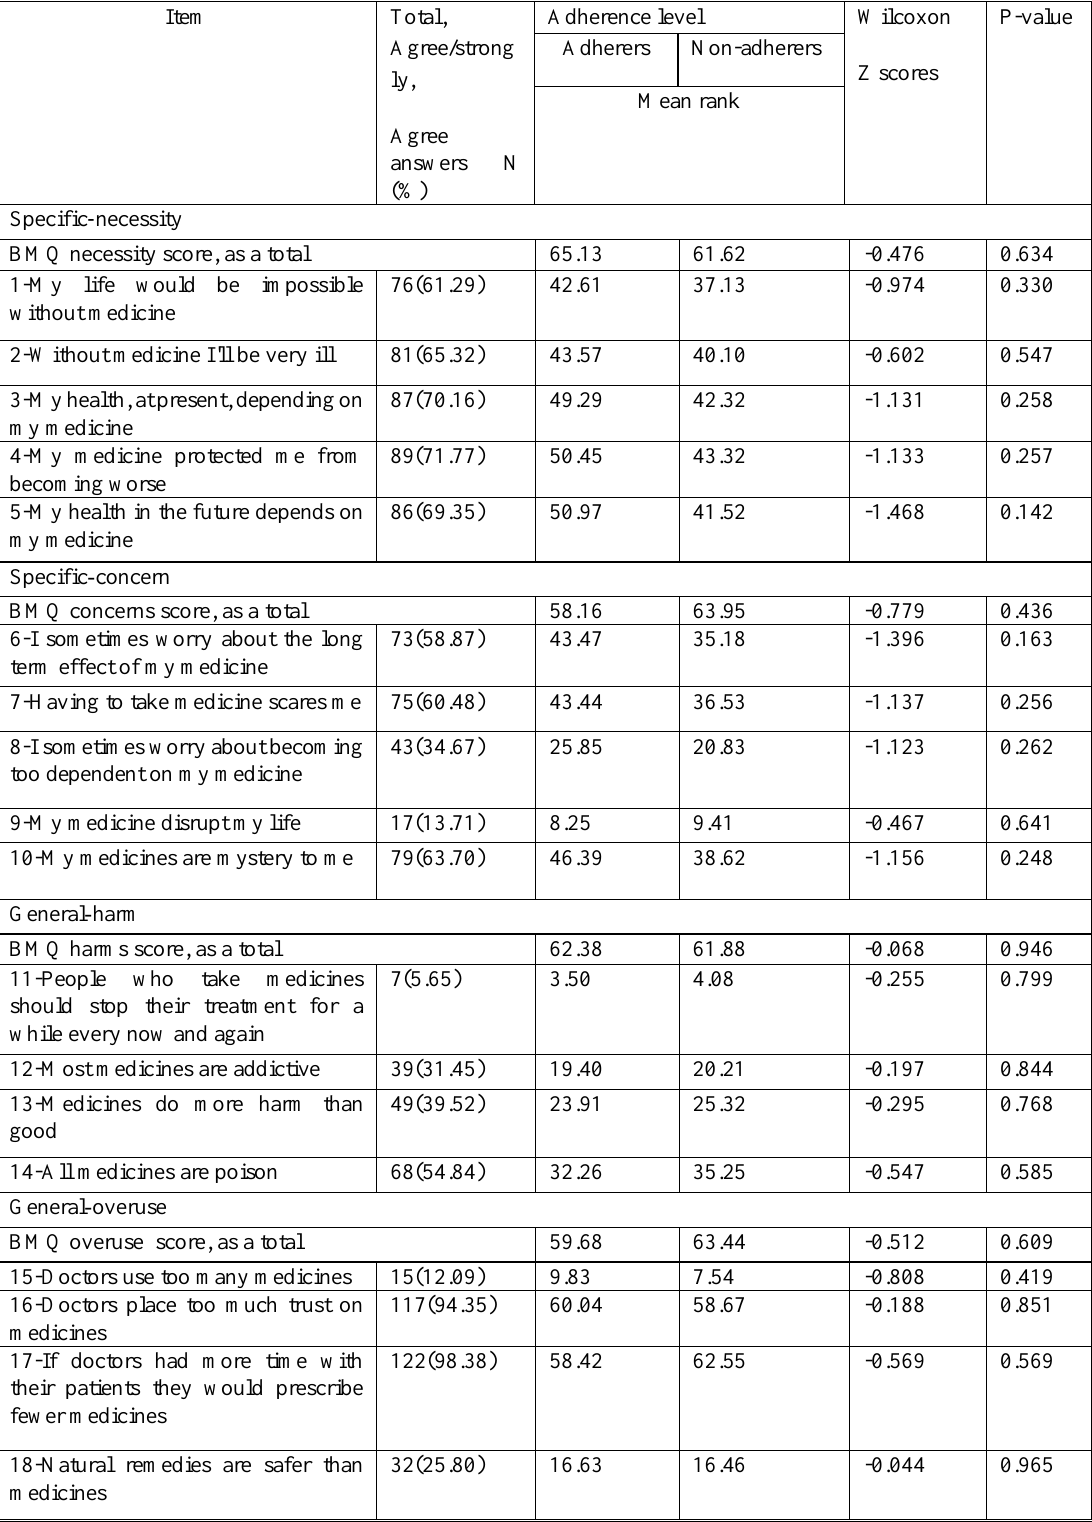
Table 4.Response to BMQ items and participants’ scores for each item by adherence